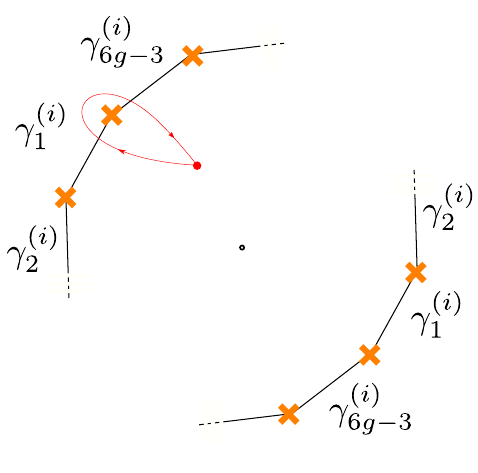
Figure 17. BPS graph of the class S theory of type A 1 on a genus- g Riemann surface C with one regular puncture. Here C is presented as a (12 g (cid:0) 4)-gon with a puncture in the middle, and where opposite sides are